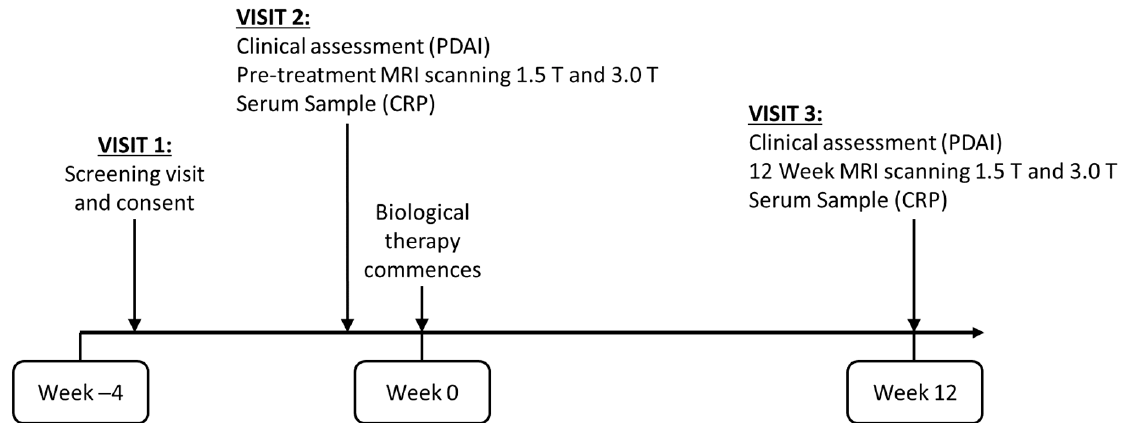
Figure 1. Patient journey. Nottingham and Manchester patients attended a maximum of 3 visits, and London patients a maximum of 5 visits, as the MRIs were not on the same day. Their clinical assessment and serum samples were collected at the 1.5 T visit.